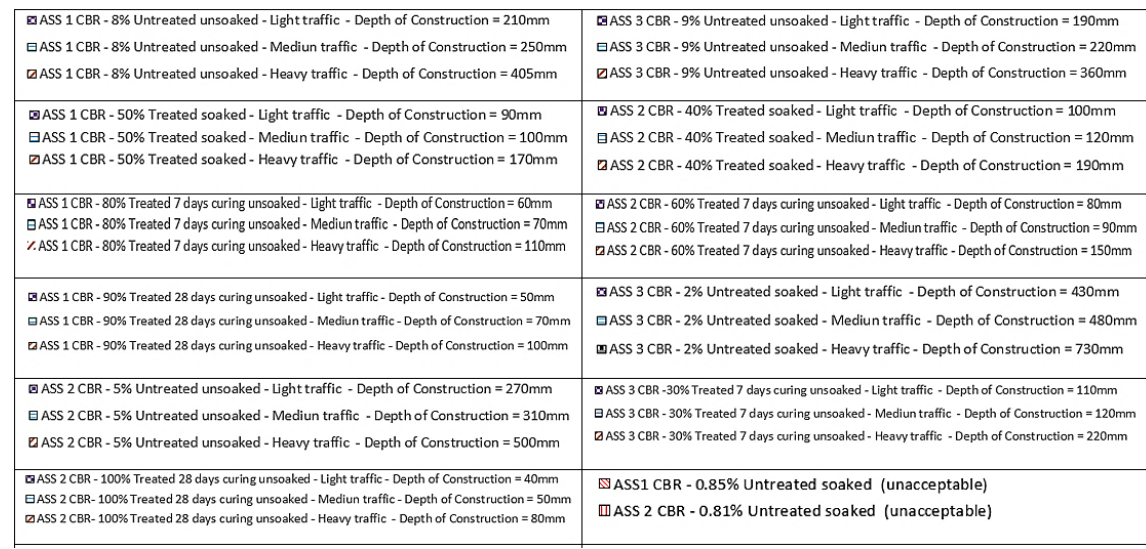
Figure 15. Pavement depths determination using the chart for construction depth determination.